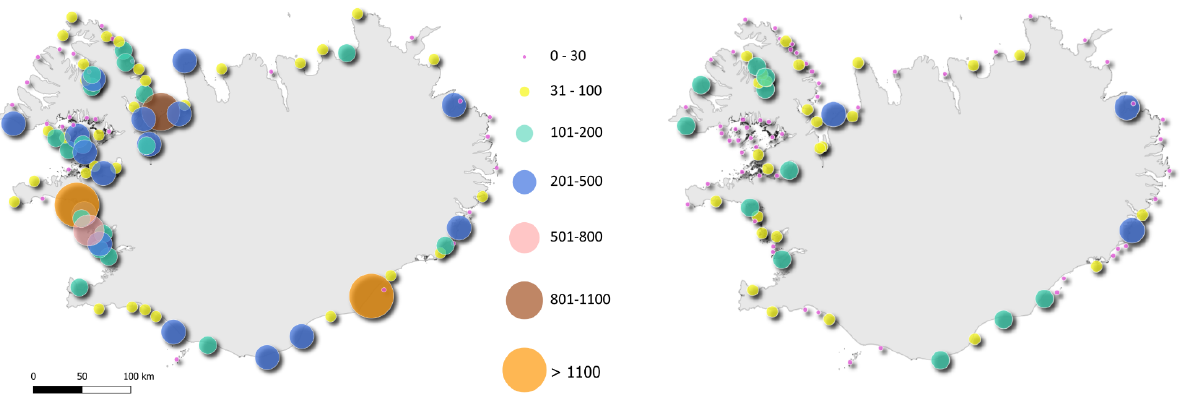
Figure 4: The 98 counting areas are indicated by circles (the circles refer to the middle of each counting area and do not represent the exact placement of individual haul-out sites since counting areas often consist of several haul-out sites). The size of the circles indicates the number of harbour seals in each counting area in the census from 1980 (first census, left) and the census from 2020 (the most recent census, right). Numbers, names and trends for the counting areas can be found in Figure 1 and Supplementary Table 1